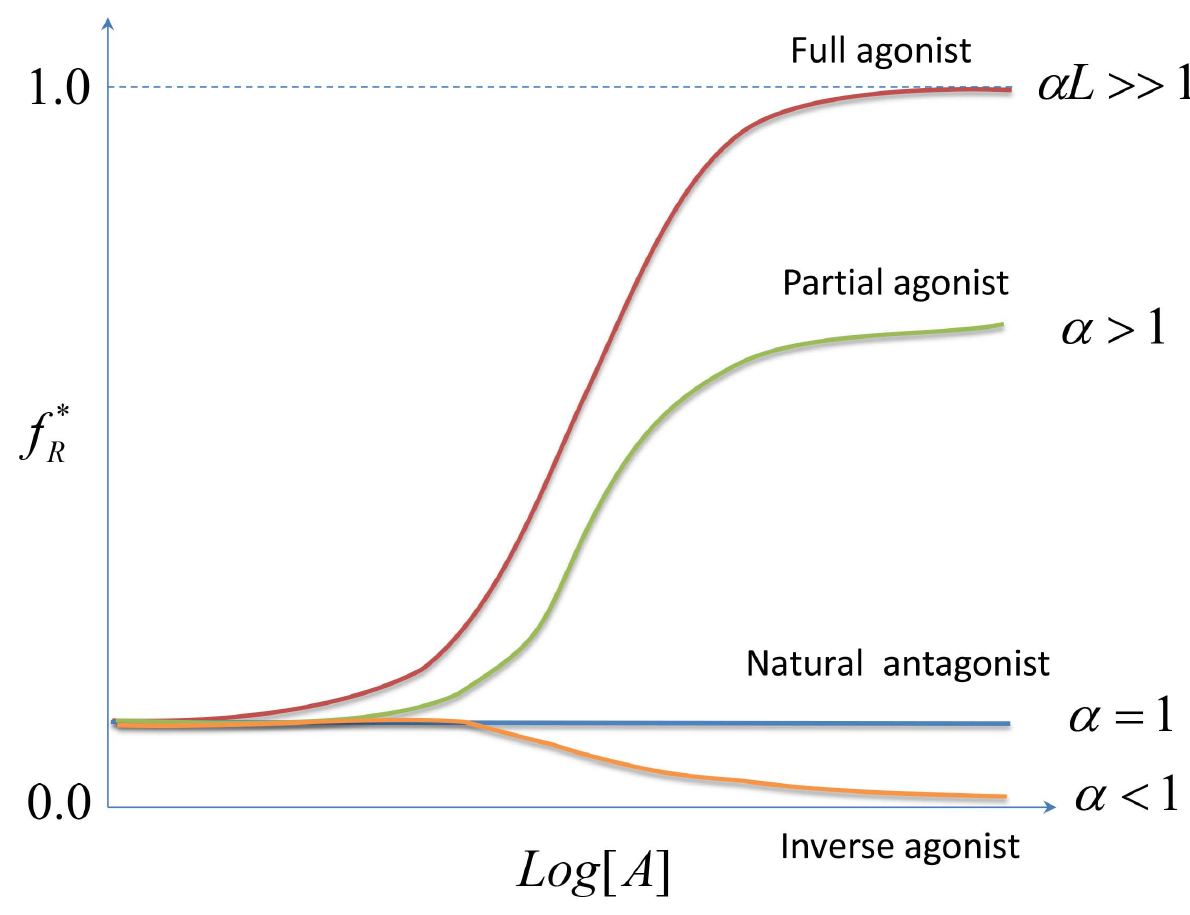
Figure 4. The classification of allosteric ligands with ATSM. Given an experimental sigmoid response-concentration curve with full biological response, we can determine the three independent parameters L , K A , and a in ATSM. Full agonist, corresponding to a L ww 1 , produces a full biological response. Partial agonist even at saturating concentration can only produce a partial biological response with a w 1 . Inverse agonist suppresses basal activity with a v 1 . Neutral antagonist with a ~ 1 does not impose any biological